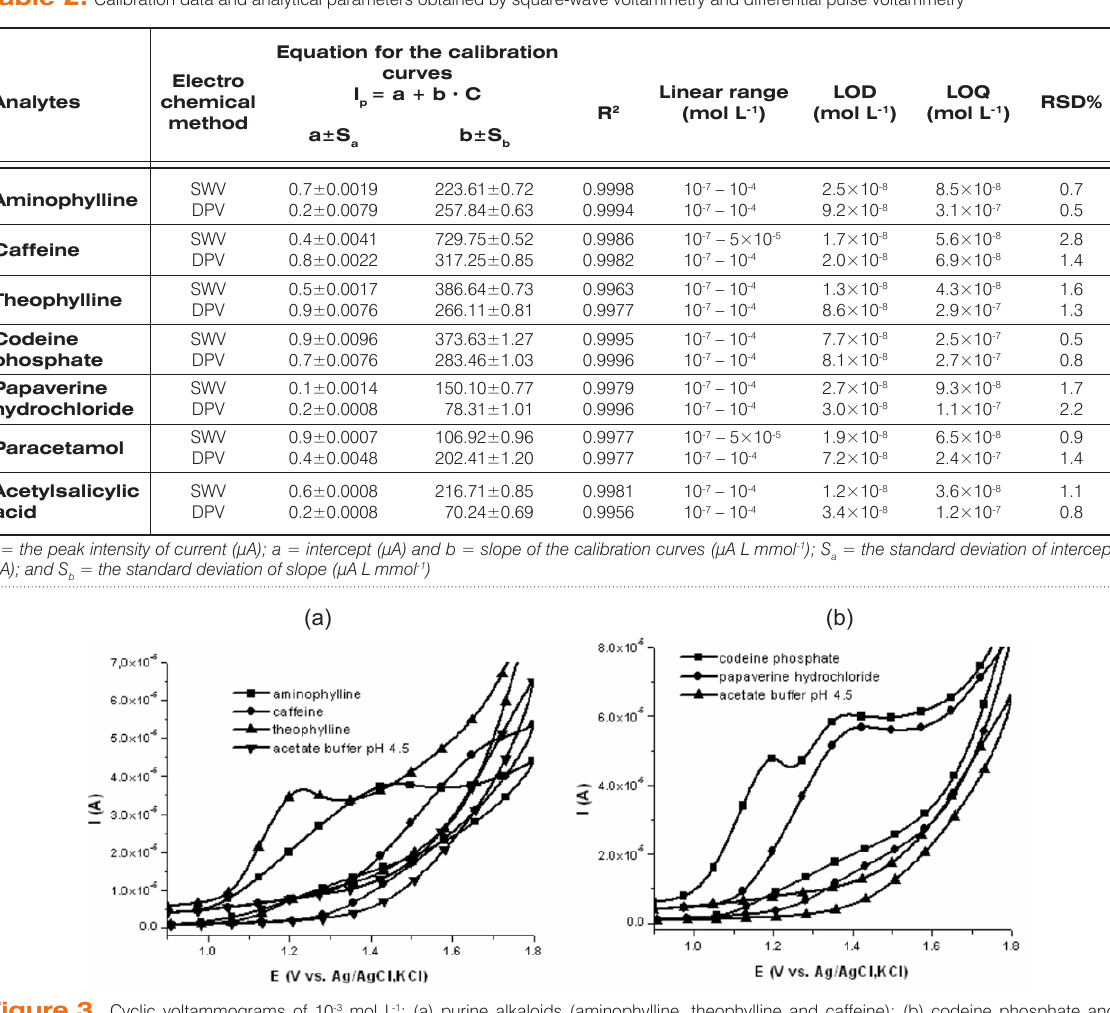
Table 2. Calibration data and analytical parameters obtained by square-wave voltammetry and differential pulse voltammetry